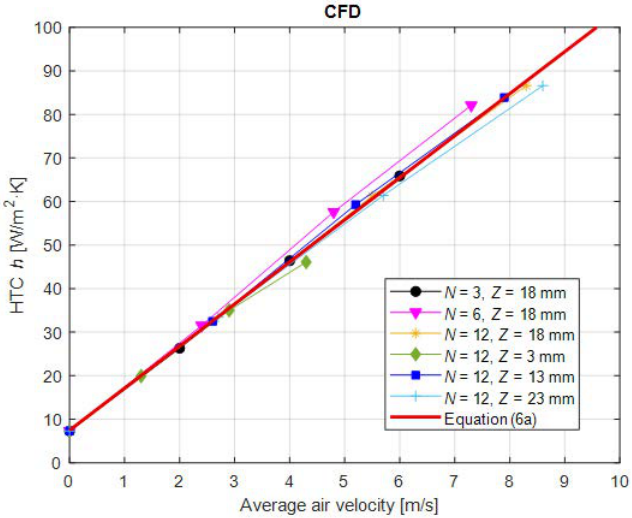
Figure 11. HTC h dependence on average air velocity in the end-winding region for variety of blade configurations. Values gained from CFD